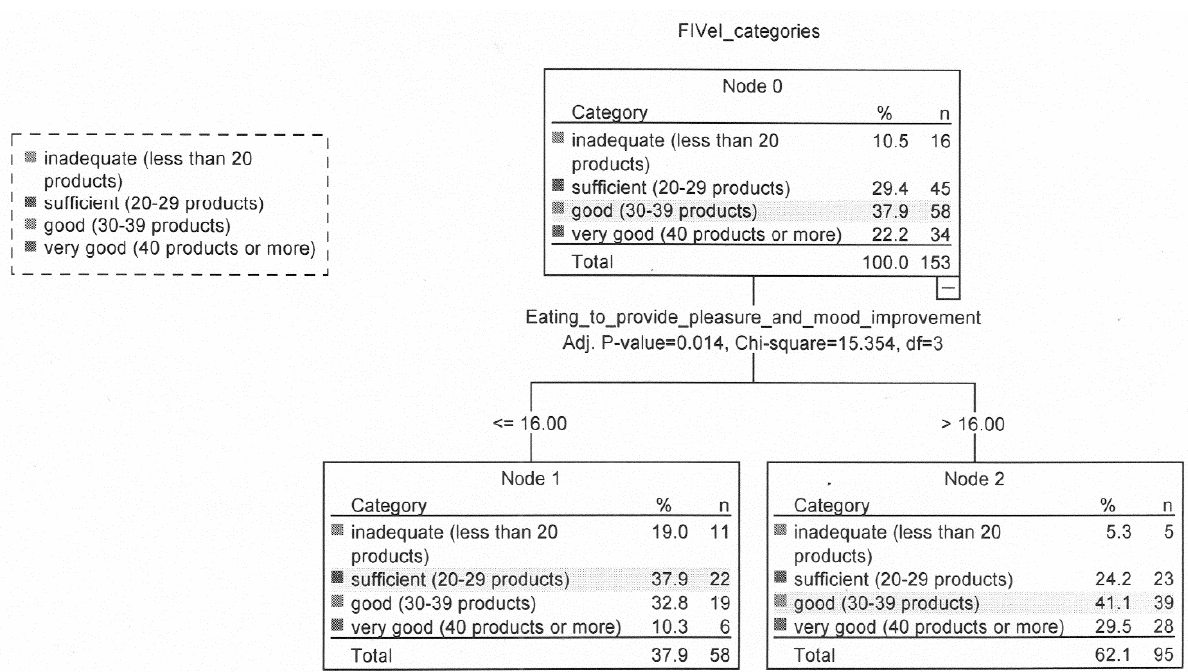
Figure 2. Relationship between food intake variety, eating addiction, selected lifestyles variables and sociodemographic characteristics in the group with